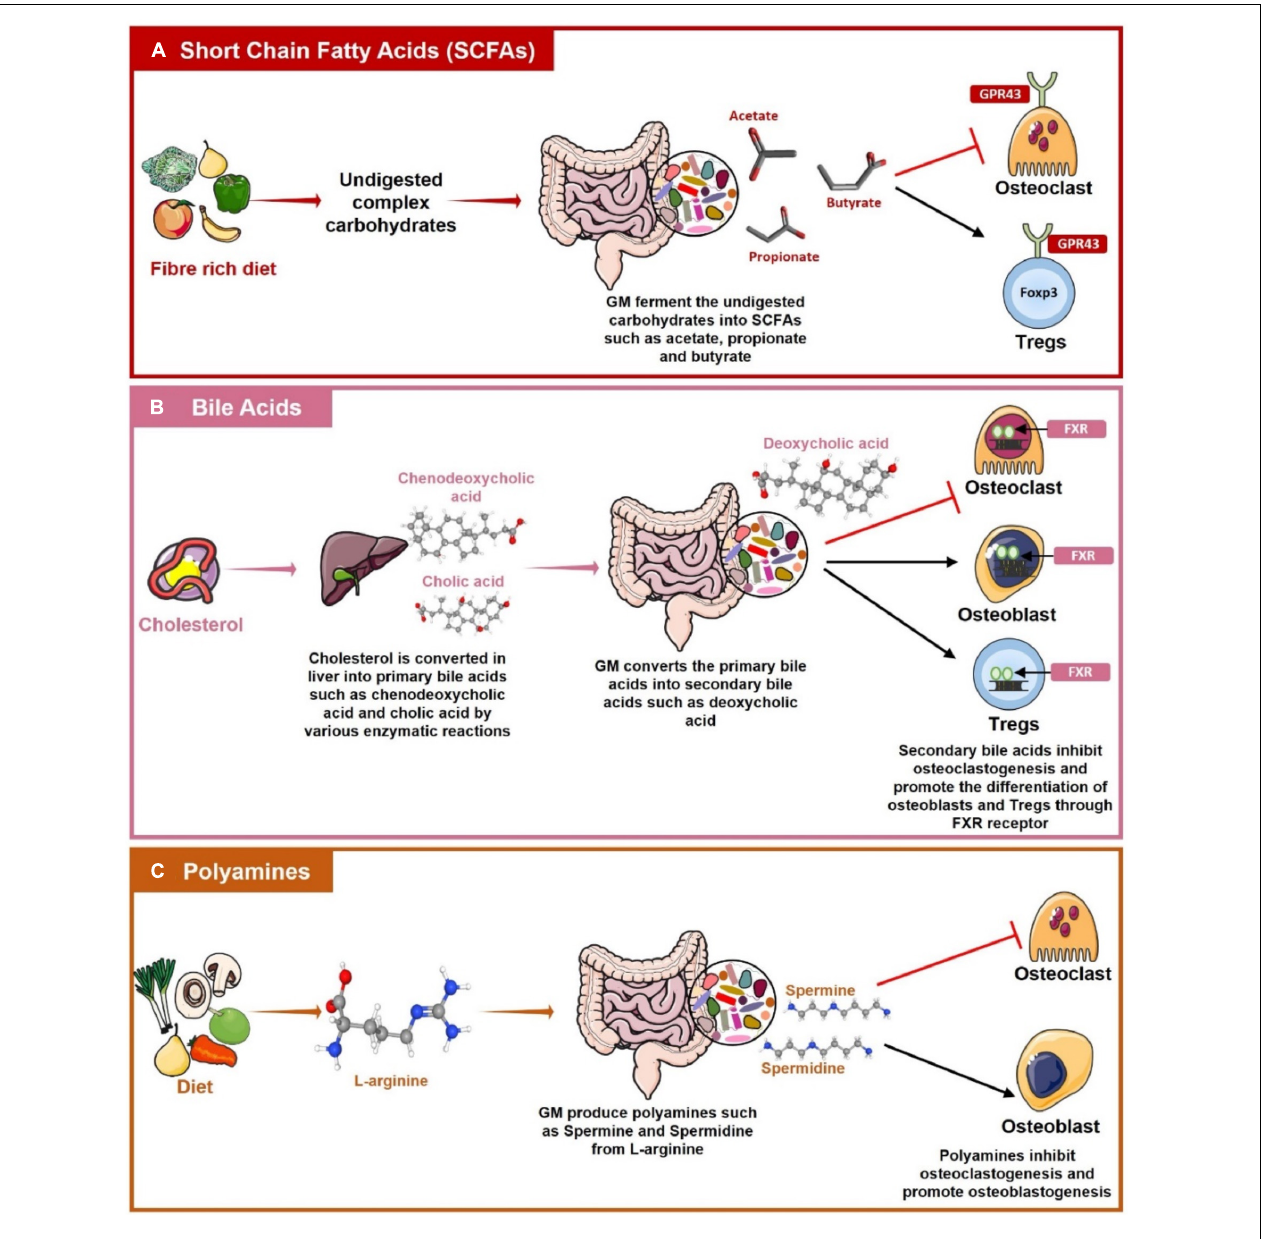
FIGURE 5 | Role of Gut Associated Metabolites (GAMs) in regulating Bone Health. (A) Gut microbiota (GM) produces short-chain fatty acids (SCFAs) such as acetate, propionate, and butyrate by the fermentation of dietary fibers. SCFAs then regulate bone health by inhibiting osteoclastogenesis and by promoting the differentiation of Tregs with the help of G-protein coupled receptor (GPR)-43. (B) Primary bile acids such as cholic acid and chenodeoxycholic acid are produced in the liver from cholesterol. These primary bile acids reach the intestine where GM converts them into secondary bile acids such as deoxycholic acids. Bile acids inhibit osteoclastogenesis whereas inducing osteoblasts and Tregs differentiation by interacting with Farnesoid X receptor (FXR). (C) L-arginine produced from the diet is metabolized by the GM into polyamines such as Spermine and Spermidine which have a role in suppressing osteoclastogenesis and promoting